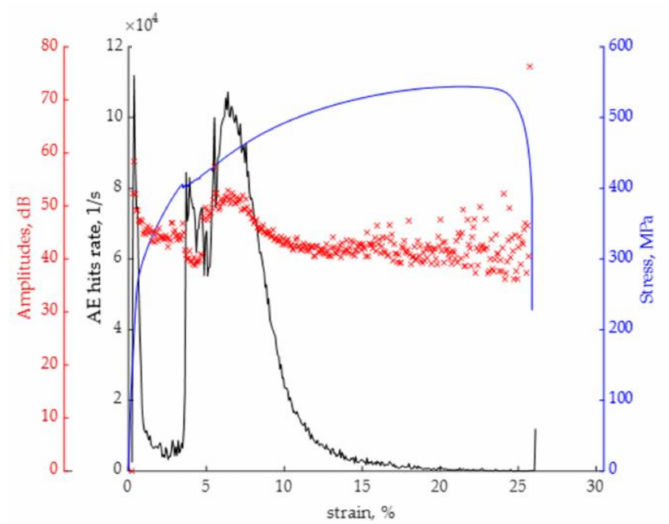
Figure 4. AE data recorded under tension of a specimen with a dissimilar welded joint of 12Kh18N10T to 09G2S steels without diffusion interlayers. All three data arrays (stress—blue, AE hits rate—black, and AE amplitude—red) depend on the same argument (strain,